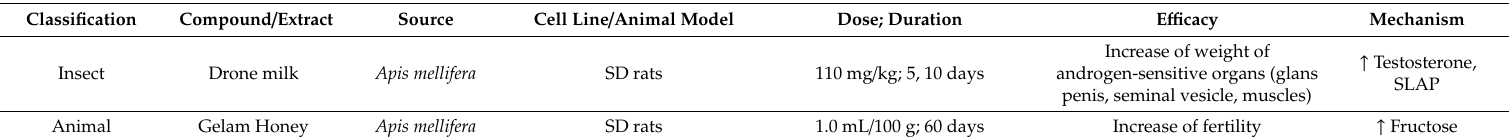
Table 4. Animal derived natural products and male